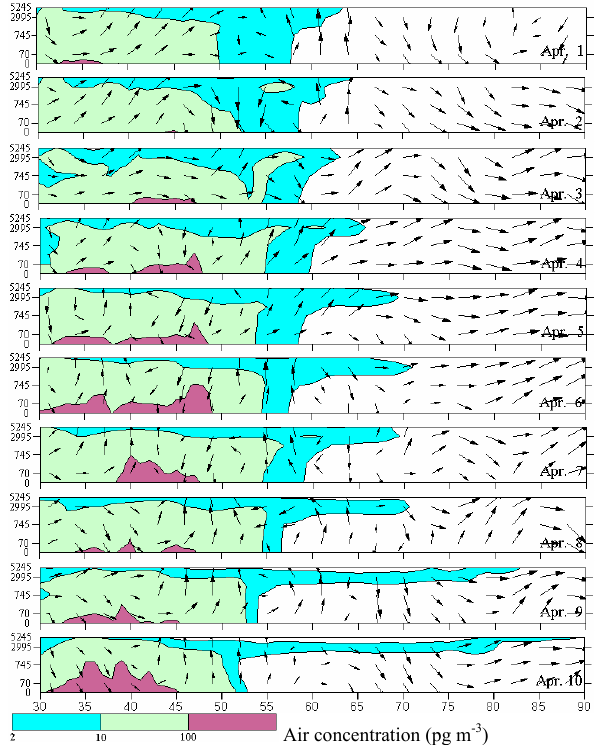
Fig. 4 Fig. 4. Vertical cross section of MEDIA modeled mean daily lin- dane air concentration (pgm − 3 ) from the surface to about 5200m model atmospheric height for 1–10 April 1997, averaged over lon- gitude 110 ◦ E to 140 ◦ W. Figure also shows cross-section of daily mean vector winds by meridional wind and vertical velocity, aver- aged over the same region and over the same period. In the pre- sentation of the vector winds, the vertical velocity w is multiplied by 100. Because the MEDIA was established on a pressure ( σ -) vertical coordinate, the model vertical height (y-axis) was obtained based on the pressure level of the